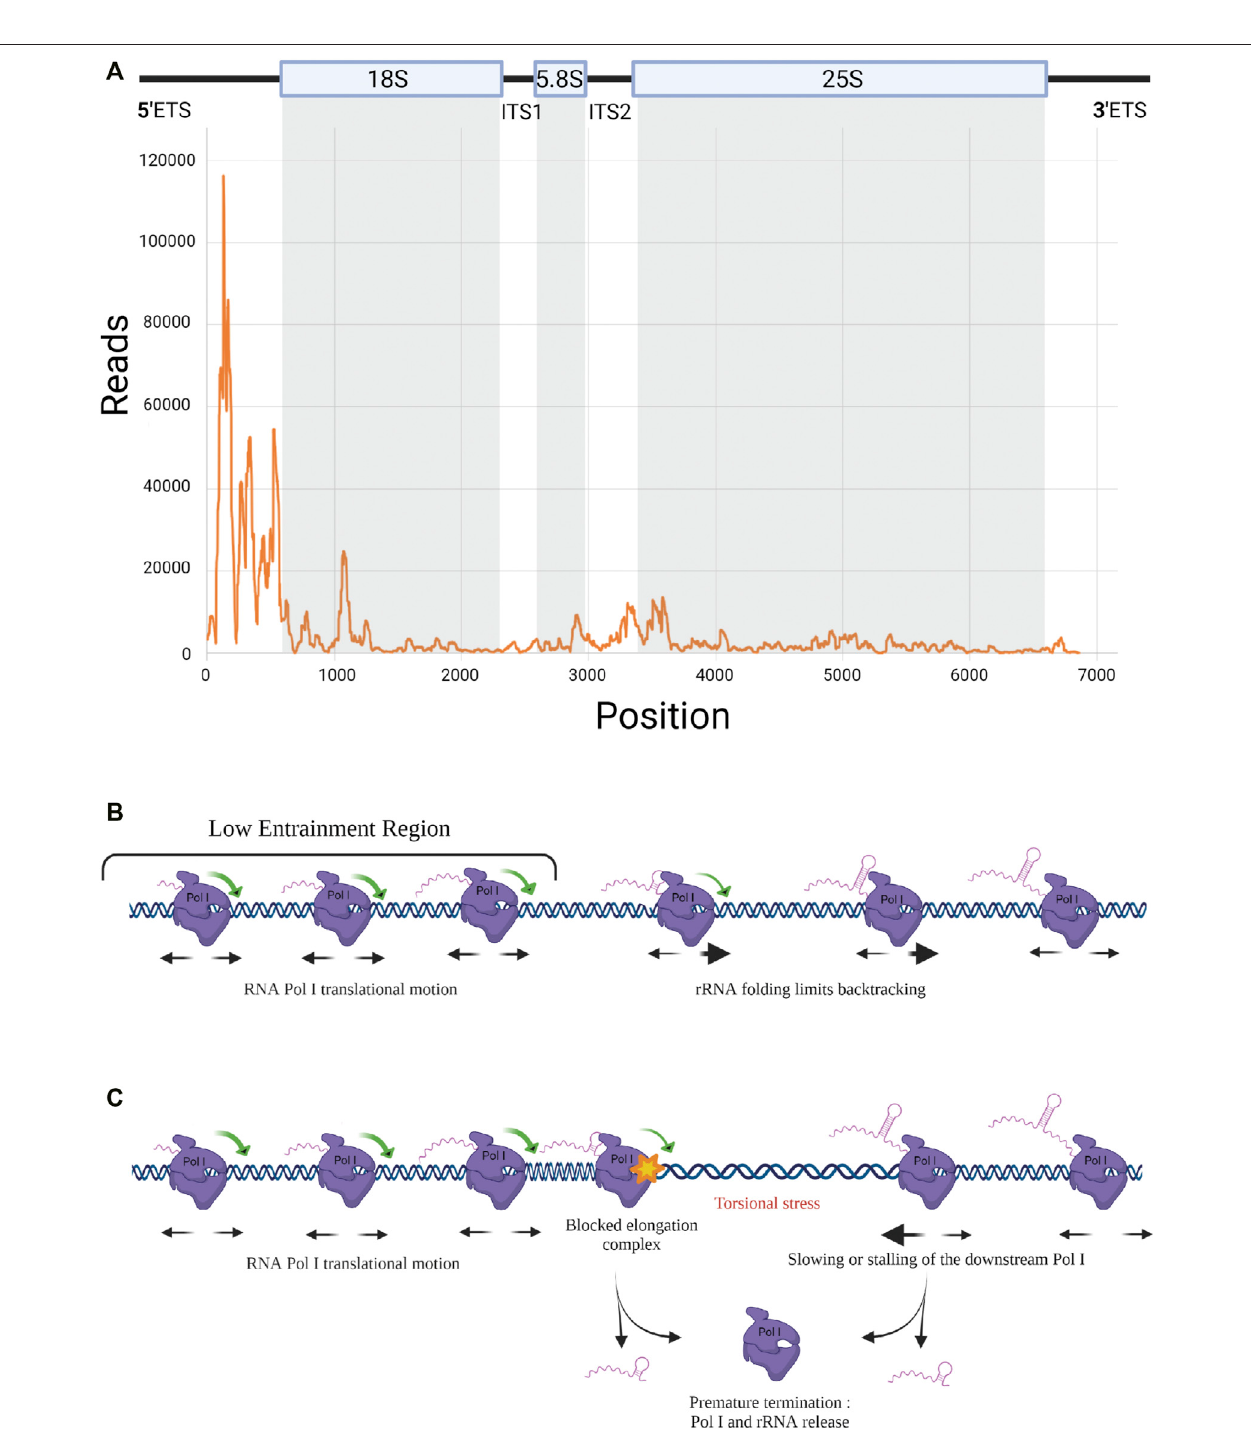
FIGURE 2 | RNA Pol I elongation dynamics. (A) RNA Pol I distribution along rDNA template. Rpa135-CRAC results showing strong Pol I accumulation at 5 ’ end of the rRNA gene (Turowski et al., 2020). (B) Elongation dynamics in the Low Entrainment Region. Schematic representation of Pol I elongation dynamics in the LER (Turowski et al., 2020). Associated with short nascent transcripts, Pol I can easily rotate around rDNA in the 5 ’ region, leading to free translocation and a higher rate of backtracking. Beyond the LER, viscous drag limits the rotation of the pre-RNA/Pol I complex around DNA. (C) Premature termination. Model including the propensity of the elongation complex to dissociate and release rRNA, leading to premature termination. When a Pol I is stalled, a torsional stress occurs that could be resolved by a premature transcription termination (PTT) event.